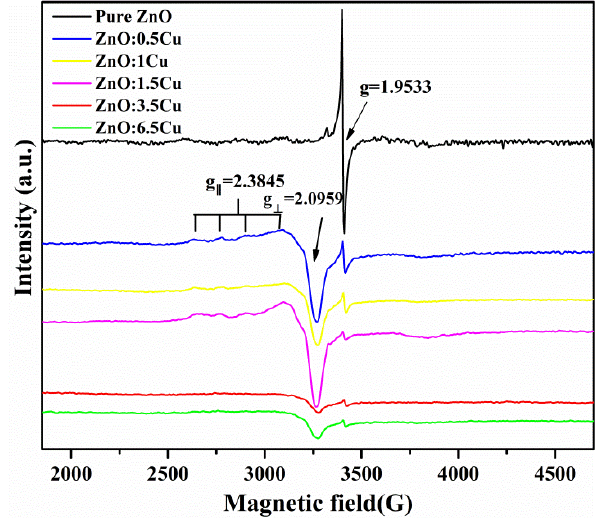
Figure 2. Electron paramagnetic resonance (EPR) profiles of the as-synthesized pure plate ZnO and = 0.5, 1.0, 1.5, 3.5, ZnO:XCu, X = 0.5, 1.0, 1.5, 3.5, 6.5. ZnO:XCu, X